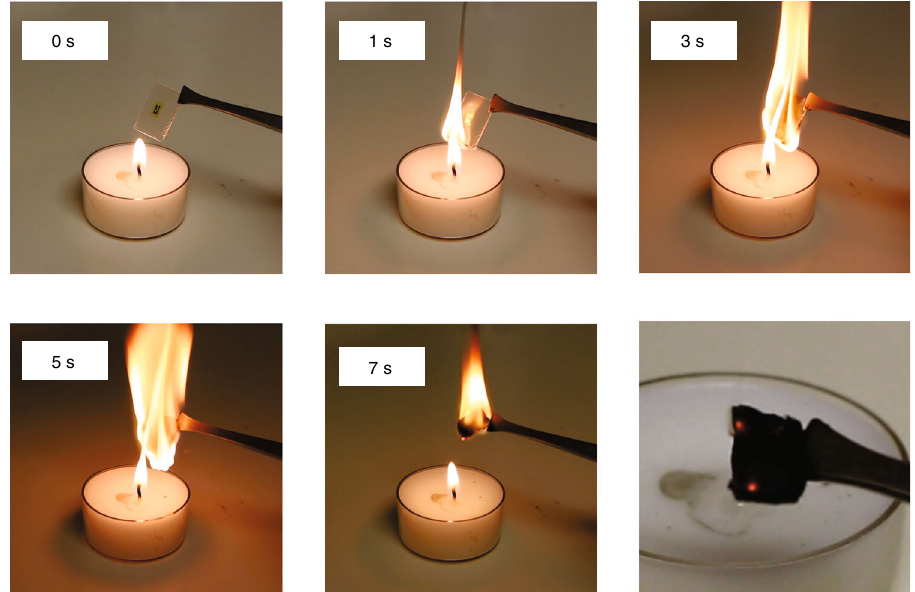
Fig. 6 Disposal of microwave ampli fi er. Photographs of an ampli fi er at different stages of incineration. The disposal of the ampli fi er was complete in 7 s. The photograph at the bottom right shows the residue of the ampli fi er after